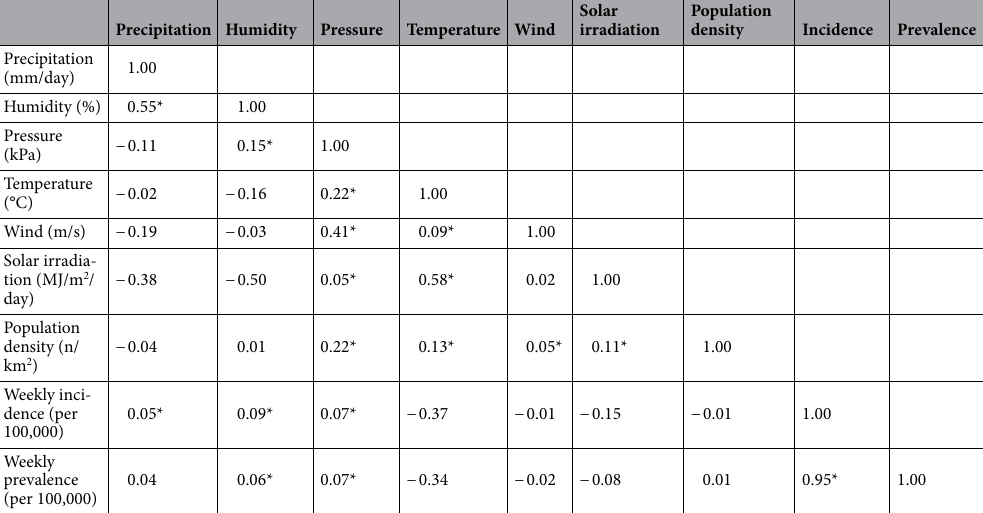
Table 2. Spearman’s rank correlation coefficient between meteorological variables, weekly incidence and weekly prevalence of SARS-CoV-2, and population density . *p < 0.05.